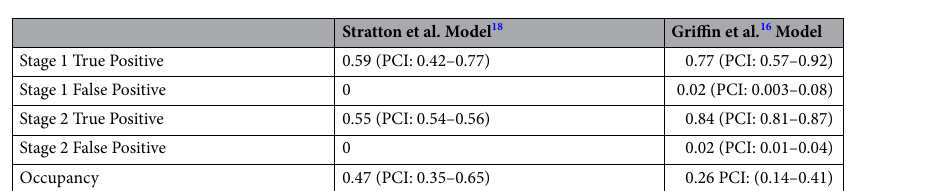
Table 1. Posterior mean estimates and 95% CI for occupancy, true and false positive error estimates using both the Stratton et al . 18 model and Griffin et al . 16